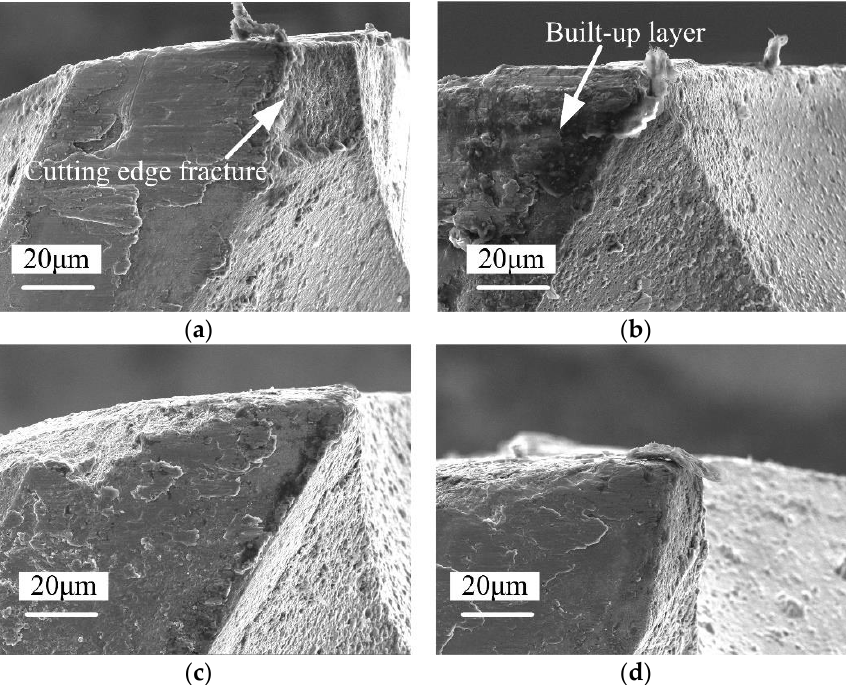
Figure 4. Flank face surface wear morphologies of micro end mills with different coating materials ( v c = 20 m/min, f z = 2 μm/z, a p = 50 μm, 640 mm). ( a ) Uncoated micro end mill; ( b ) AlCrN-based coated micro end mill; ( c ) AlTiN-based coated micro end mill; ( d ) TiN coated micro end